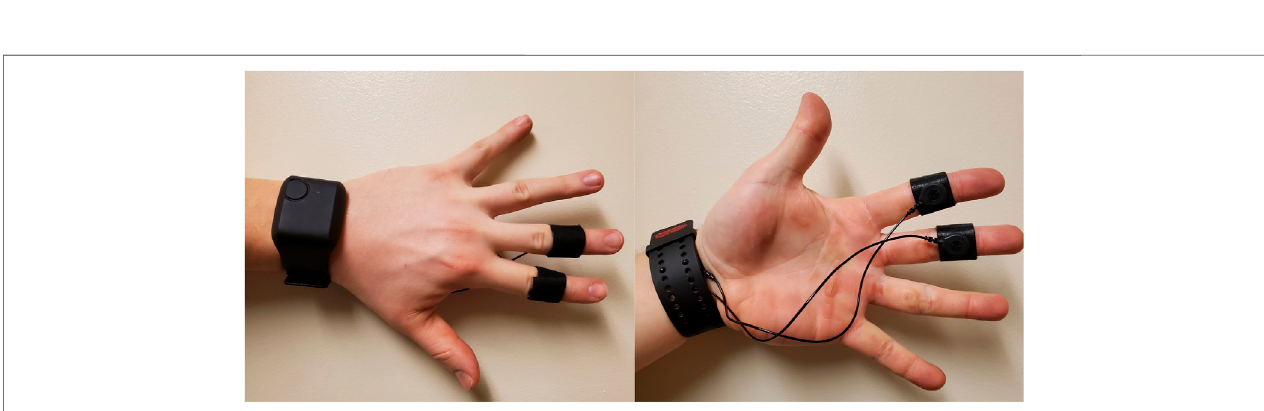
FIGURE 1 | Participants were exposed to two virtual environments over the course of 5 days. On days 1 and 5, participants navigated a naturalistic environment, which served as the baseline and test for adaptation. On days 2 through 4, participants navigated an optokinetic labyrinth with an increase in the luminance contrast on each day. Participants used blue particle cloud waypoints and arrow textures to help guide their navigation.